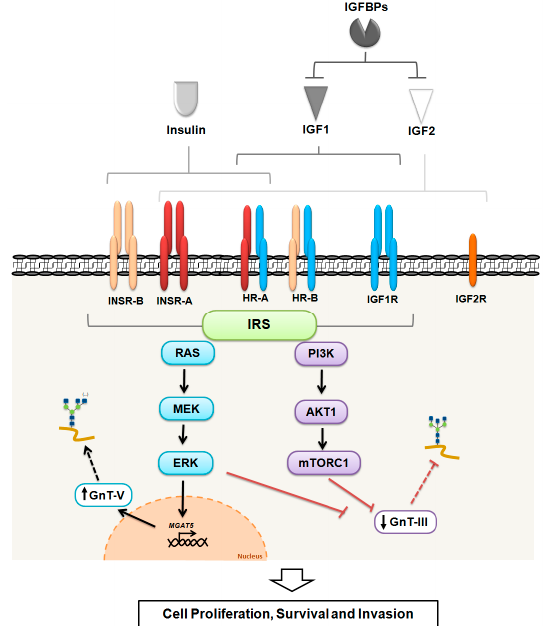
Figure 1. The insulin/insulin-like growth factor (IGF) system. The ligands (insulin, IGF1 and IGF2) bind to their specific receptors triggering downstream signaling pathways (RAS/MEK/ERK and PI3K/AKT1/mTORC1) through IRS proteins, with the exception of IGFR2 that does not transduce signaling. The IGFBPs negatively modulate both IGF1 and IGF2. The activation of RAS/MEK/ERK